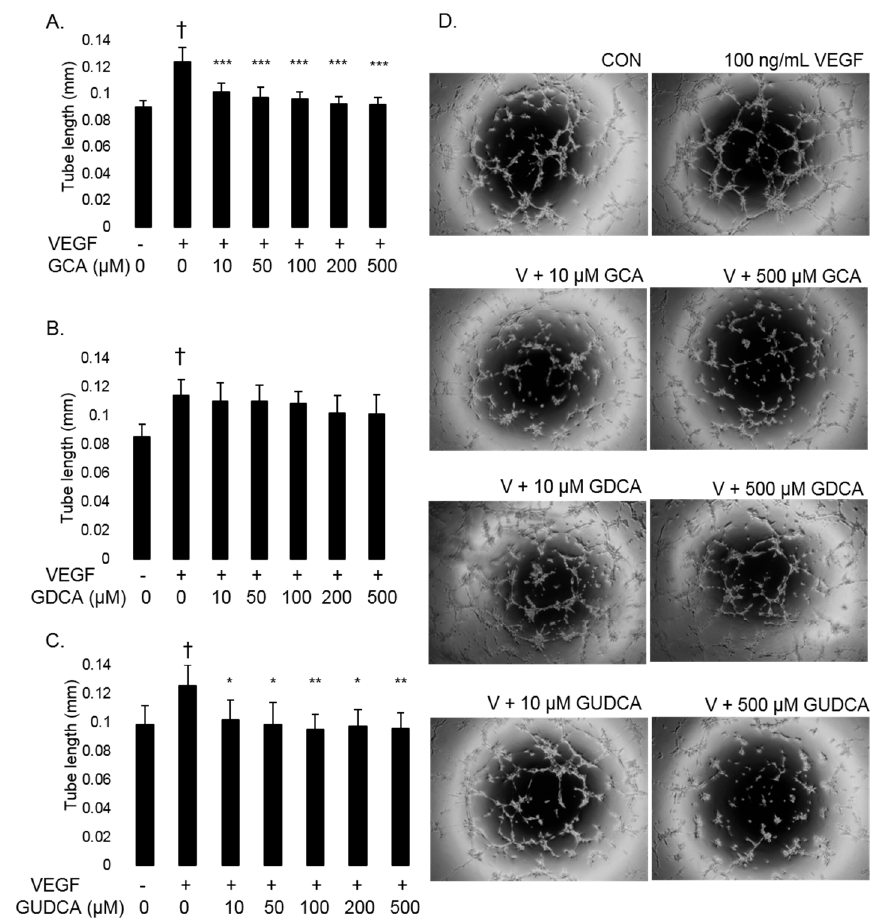
Figure 4. GCA and GUDCA inhibit VEGF-induced tube formation in RF/6A cells. RF/6A tube formation was induced by treating cells with 100 ng/mL VEGF (V). Cells were treated with GCA, GDCA, or GUDCA (10, 50, 100, 200, or 500 µM) to evaluate their ability to inhibit tubulogenesis. ( A ) VEGF induced tube formation compared to untreated cells (†: p = 1.7 × 10 − 4 ). RF/6A cells treated with VEGF and GCA resulted in significantly shorter tube length at 10, 50, 100, 200, and 500 µM. ( B ) VEGF induced tube formation compared to untreated cells (†: p = 6.3 × 10 − 4 ). No concentration of GDCA resulted in significantly shorter tubes compared to cells treated with VEGF alone. ( C ) VEGF induced tube formation compared to untreated cells (†: p = 0.0074). All concentrations of GUDCA resulted in significantly shorter tubes compared to cells treated with VEGF alone. Data are presented as average tube length ± standard deviation ( n = 6). *: p < 0.05; **: p < 0.01; ***: p < 0.001 for bile acid-treated cells compared to VEGF-treated cells. ( D ) Representative images of tube formation of untreated controls (CON), cells treated with 100 ng/mL VEGF (V), and cells treated with VEGF plus 10 µ M and 500 µ M concentrations of GCA, GDCA, and